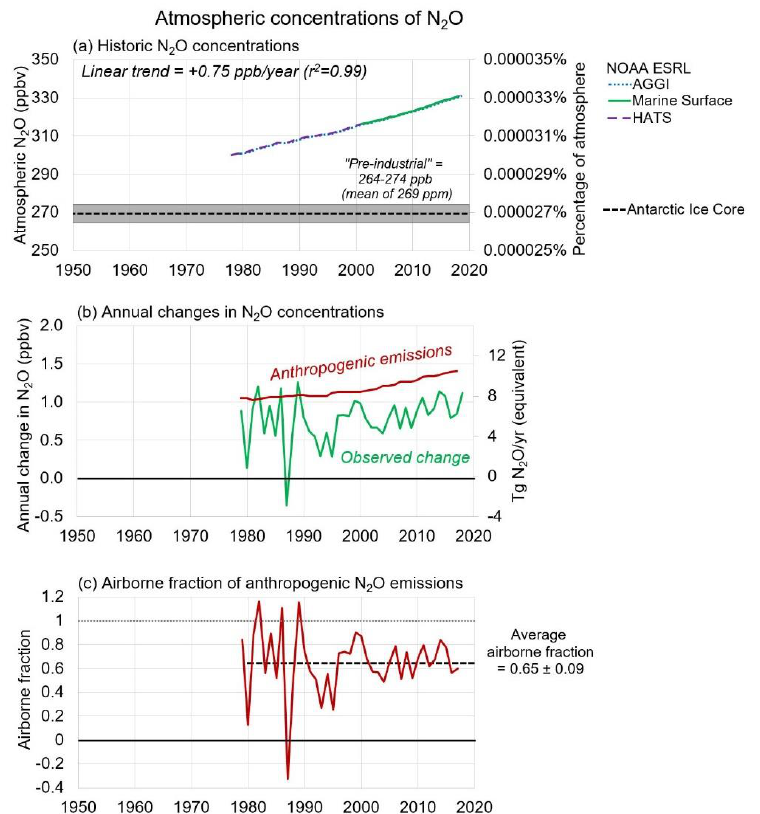
Figure 8. ( a ) Changes in annually averaged atmospheric N 2 O concentrations since direct and (almost) continuous measurements began in 1979. The estimates of pre-industrial concentrations derived from the Antarctic Law Dome ice core are shown with a grey band for comparison. ( b ) A comparison of the annual anthropogenic N 2 O emissions (red line) with the observed annual changes in atmospheric N 2 O (green line). ( c ) The “airborne fraction” for N 2 O, i.e., the fraction of anthropogenic N 2 O emissions that remained in the atmosphere for each year since 1980. Note that the airborne fraction was below 0 in one year (1987) and above 1 in three years (1982, 1986 and 1989). The horizontal axes correspond to years.